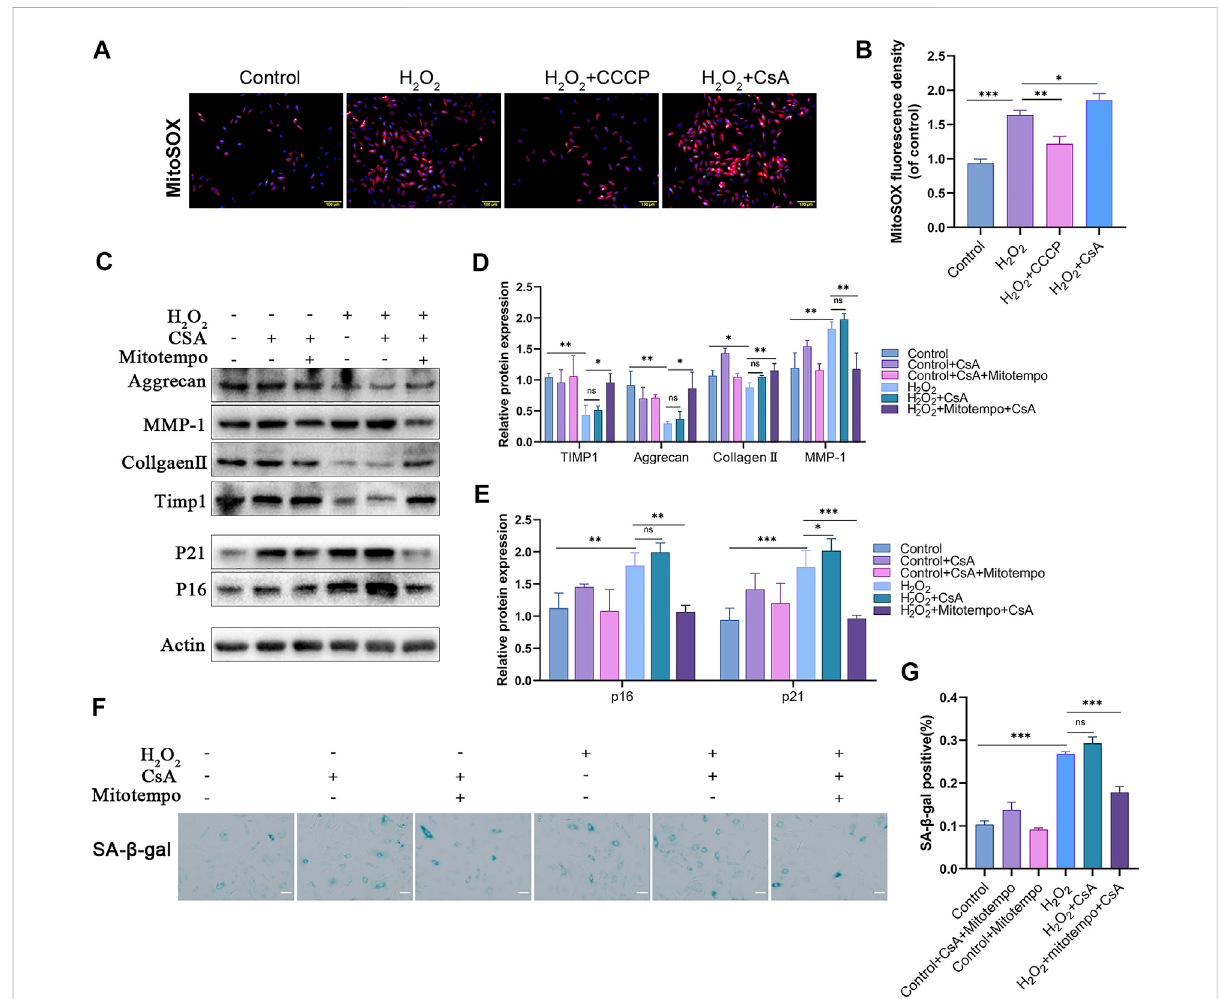
FIGURE 4 Mitophagy attenuates H 2 O 2 -induced rat NPCs damage by scavenging mtROS. (A – B) MitoSOX staining was used to detect mtROS in rat NPCs (scale bar: 50 μ m). NPCs were treated with or without H 2 O 2 conditions in the presence of CCCP, CsA. C – E ) Western blot and quanti fi cation